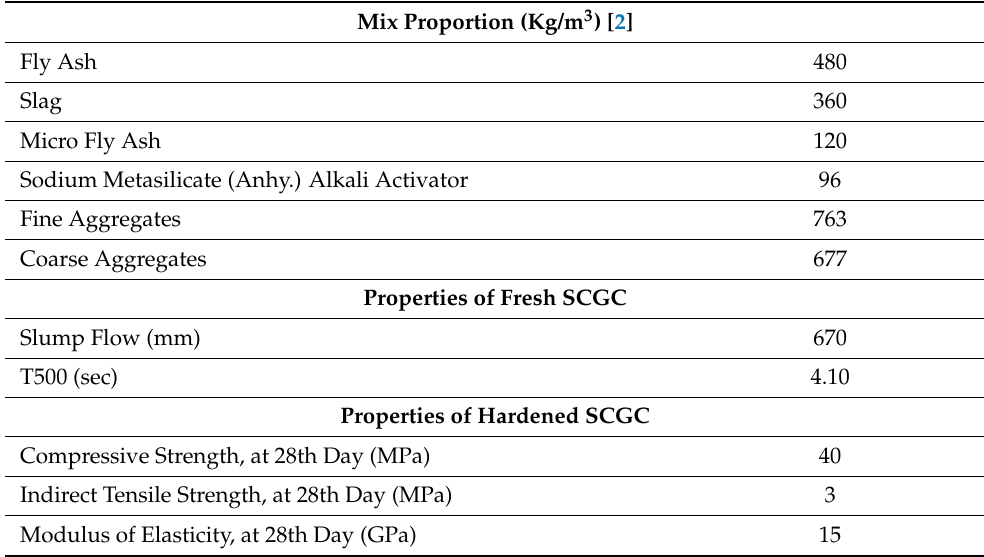
Table 2. Mix proportion and properties of self-compacting geopolymer concrete.